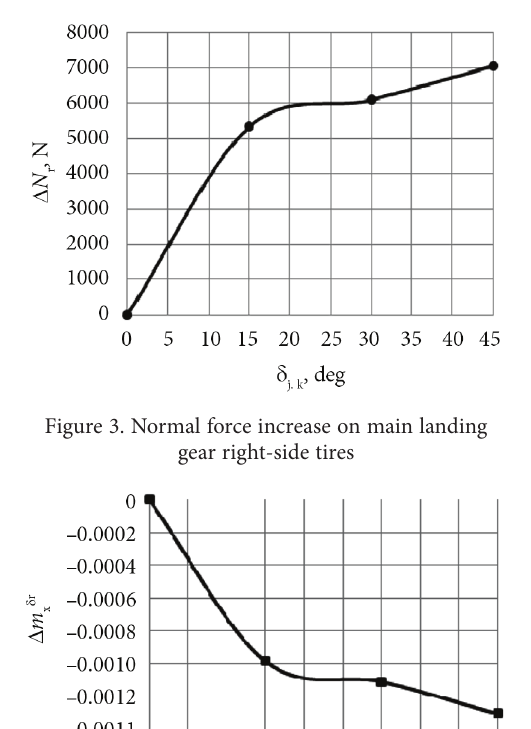
Figure 6. Change of Ry m as function of SR and SE deflection